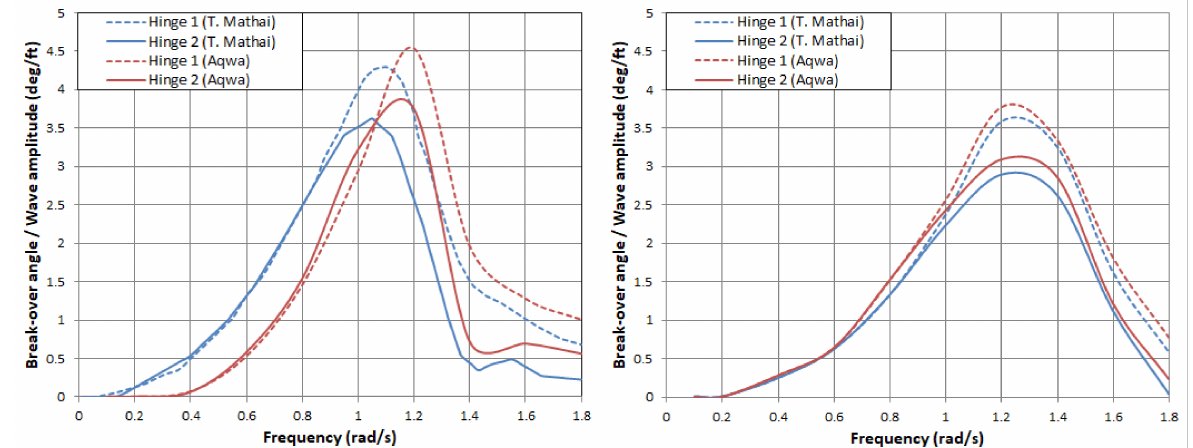
Figure 4. A comparison of the breakover angles of the triple modular assembly in following seas ( left ) and quartering seas ( right